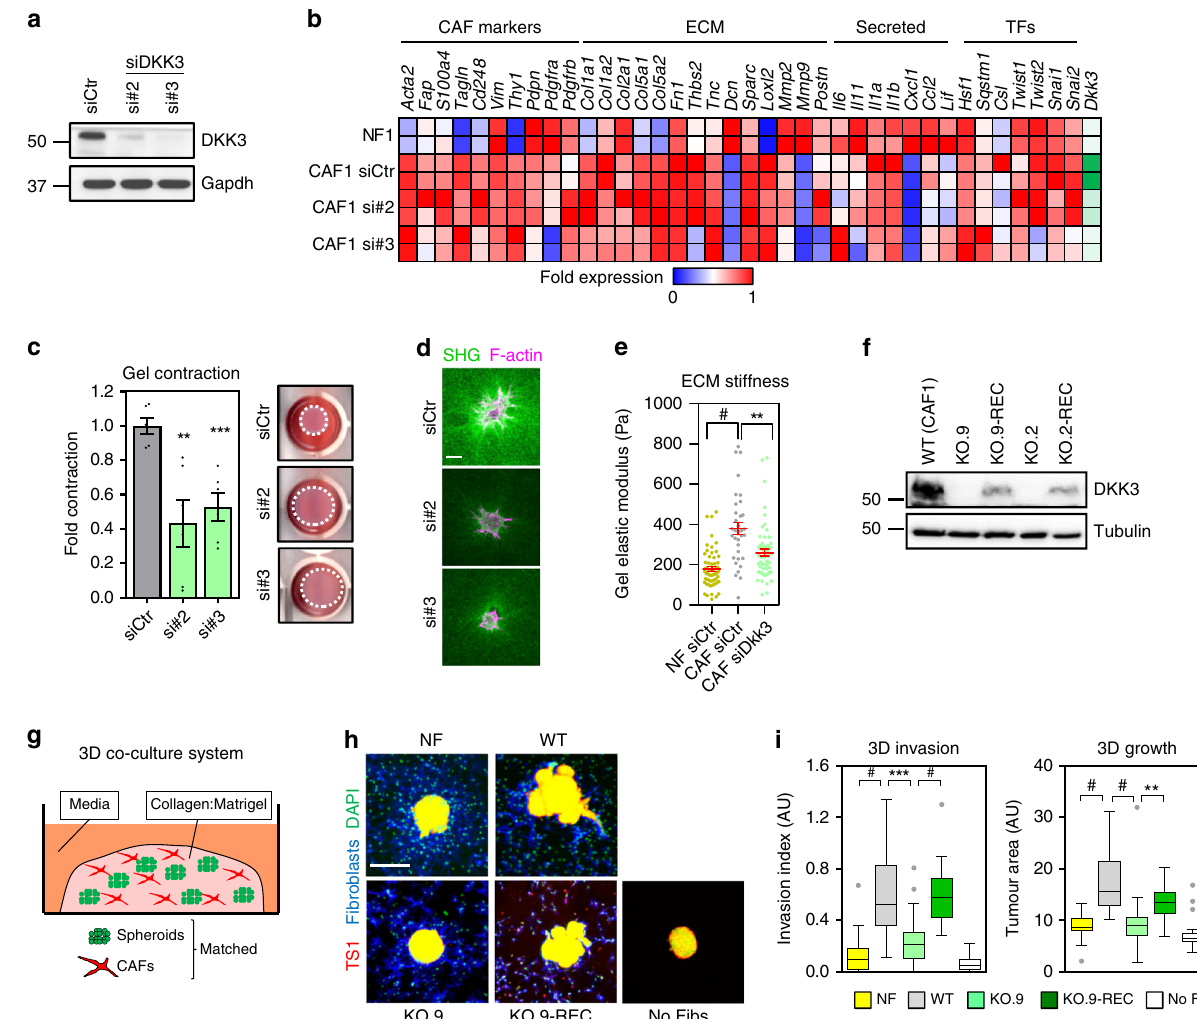
Fig. 3 DKK3 is a crucial regulator of CAF functions. a Western blots showing DKK3 and Gapdh expression in murine CAF1 after transfection with control (siCtr) and 2 independent DKK3 siRNAs (si#2 and si#3). b Colour-coded grid showing fold expression of genes generally associated to CAFs in NF4 and wild-type CAF1 after transfection with control and 2 different DKK3 siRNAs. Colours range from red to blue representing, respectively, the lowest (zero) and highest fold activity (one). Genes are grouped into CAF markers, extracellular matrix (ECM) components/remodellers, secreted factors and transcription factors (TFs). Expression for Dkk3 is shown in a scale of green colour. c Histogram shows gel contraction by CAF1 after transfection with control (siCtr) and 2 independent DKK3 siRNAs. Bars represent mean ± SEM ( n = 6). Images show representative gels remodelled. d Images show F-actin (magenta) and collagen second harmonic (SHG, green) in gels remodelled by CAF1 after transfection with control (siCtr) and 2 different DKK3 siRNA. Scale bar, 50 µ m. e Histogram shows Young ’ s elastic modulus of NF1 or CAF1 cells following transfection with control (siCtr) and DKK3 siRNA (si#sp, smart-pool). Lines represent mean ± SEM ( n = 34 or more individual measurements). f Western blot showing levels of DKK3 and tubulin in wild-type CAF1 (WT) and two sets of DKK3 knockout CAF1 clones (KO) and their recovery counterparts where DKK3 was stably re-expressed (KO-REC). g Cartoon describing the experimental set-up for the 3D co-culture system. Cancer cell spheroids are embedded in a collagen:Matrigel matrix containing fi broblasts and fed with media containing 10% FBS for 4 – 7 days. h Images show representative end-point TS1 murine breast cancer spheroids (red) obtained after 3D co-culture with WT, KO.9 and KO.9-REC CAFs (in blue). Spheroids obtained by mono-culture or by co-culture with NFs (in blue) are also shown. DAPI staining (green) was also used. Scale bar, 200 µ m. i Tukey boxplots show the invasion index (3D invasion) and tumoral area (3D growth) measured from spheroids described in (h); n > 26 individual spheroids out of 3 independent experiments. Where indicated, * P < 0.05; ** P < 0.01; *** P < 0.001; # P < 0.0001; n.s., non-signi fi for degradation. Gene expression analyses indicated that YAP/TAZ was severely affected in the absence of DKK3. Further modulating DKK3 expression levels did not alter the expression analyses revealed that LRP6 levels at the cell surface were of Wnt signalling regulators (Supplementary Figure 8e). How- diminished when Dkk3 was knocked-out (Fig. 7b), suggesting that DKK3 was affecting YAP/TAZ activity and CAF functions at the level of LRP5/6. In agreement, targeting Lrp5/6 expression in WT-CAFs (Supplementary Figure 8f), attenuated β -catenin and YAP activation (Fig. 7c and Supplementary Figure 8f) and diminished their tumour-promoting activities (Fig. 7d, e). Yet, silencing Lrp5/6 expression in Dkk3-null CAFs had no functional